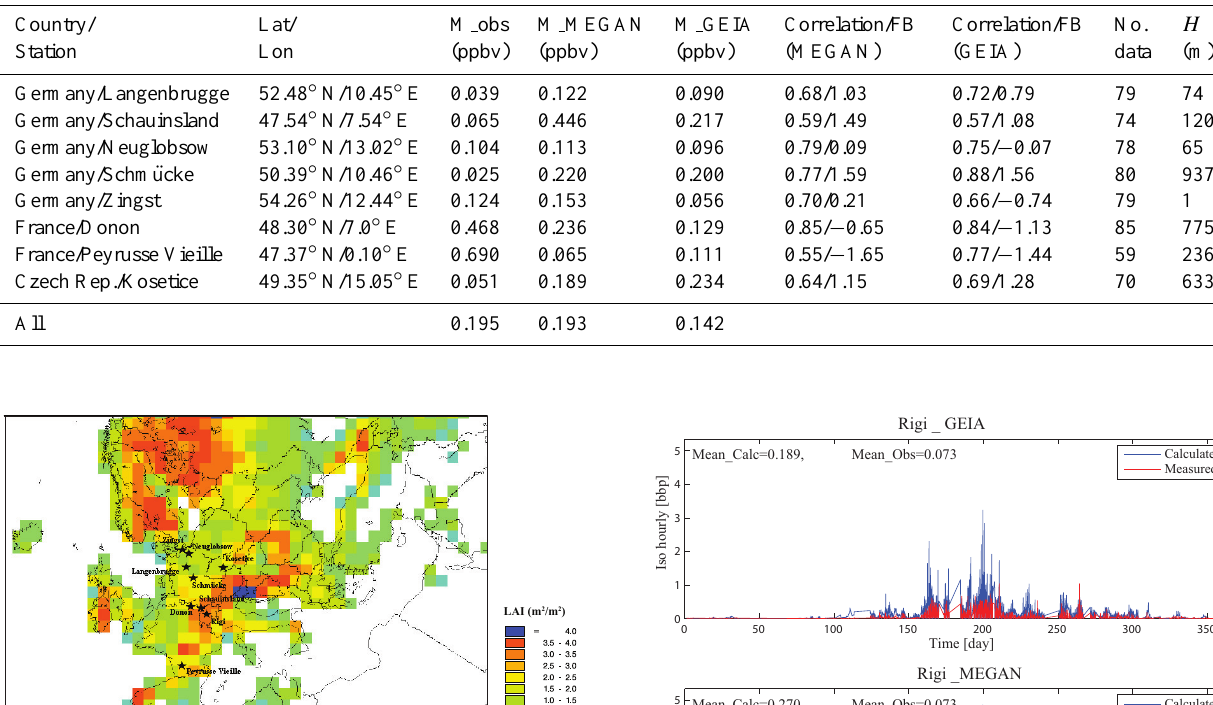
Table 1. Comparison of the mean (M) isoprene concentrations between observed and calculated data by DEHM using both biogenic models in 2006. The performance of DEHM based on both GEIA and MEGAN are evaluated using the correlation coefficient and the fractional bias (FB). H is the height of the station above sea-level.